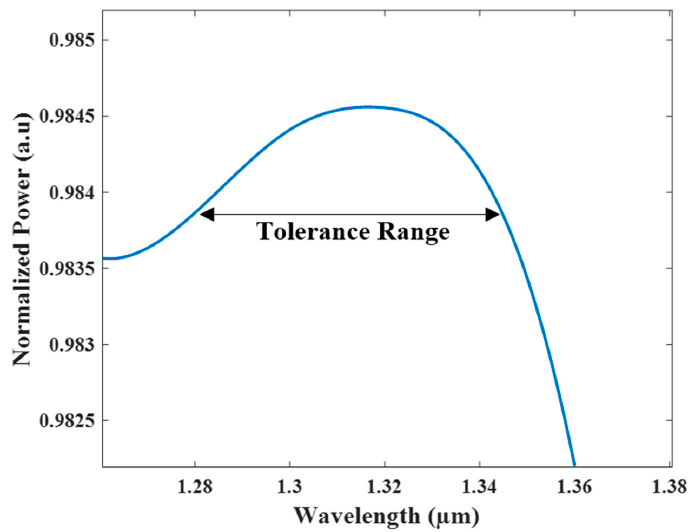
Figure 8. The normalized power of the combiner over the O-band spectrum.